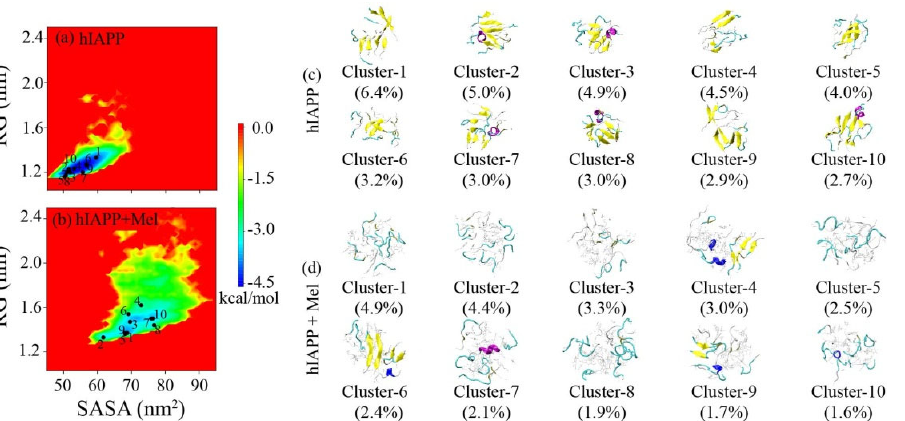
5 of 13 Figure 3. PDF of C α‐ atom RMSD ( a ), end ‐ to ‐ end distance ( b ), and H ‐ bond number of the peptide main chain ( c ) and side chain ( d ) for the hIAPP 20–29 octamer in the absence and presence of Mel. The two ‐ dimensional free energy landscape as a function of the solvent ‐ accessible surface area (SASA) and the radius of gyration (RG) of hIAPP 20–29 in Figure 4a,b display an overall view of the influence of Mel molecules on the whole conformational space of the hIAPP 20–29 octamer. In the hIAPP 20–29 system, the vast majority of conformations are in the range of SASA = 45 – 70 nm 2 and RG = 1.1 – 1.6 nm, and there is only one major free energy basin. In the hIAPP 20–29 + Mel system, the free energy surface becomes much broader, with the range of SASA expanded to 58 – 95 nm 2 and that of RG to 1.2 – 2.2 nm. There are also several local minimum energy basins within the free energy landscape. It reveals that Mel exposes more residues to the aqueous environment and makes the hIAPP 20–29 aggregates less compact.